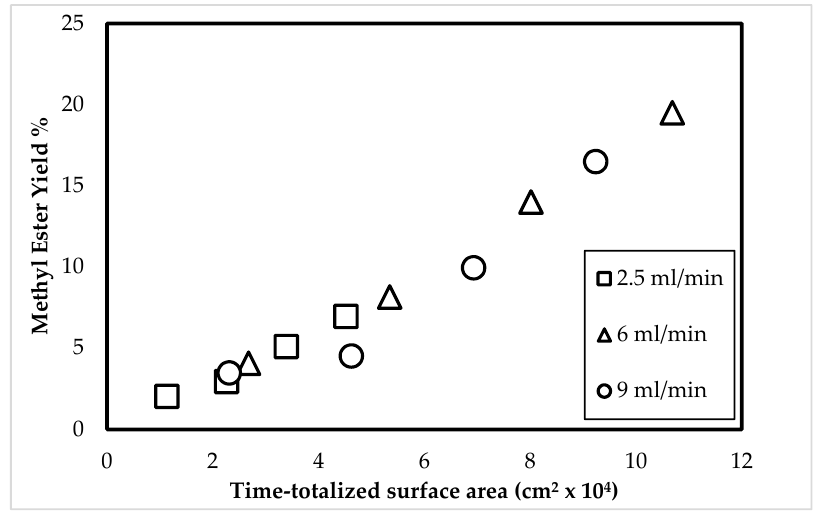
Figure 8. Effect of the time totalized surface area of the droplets on the methyl ester yield.